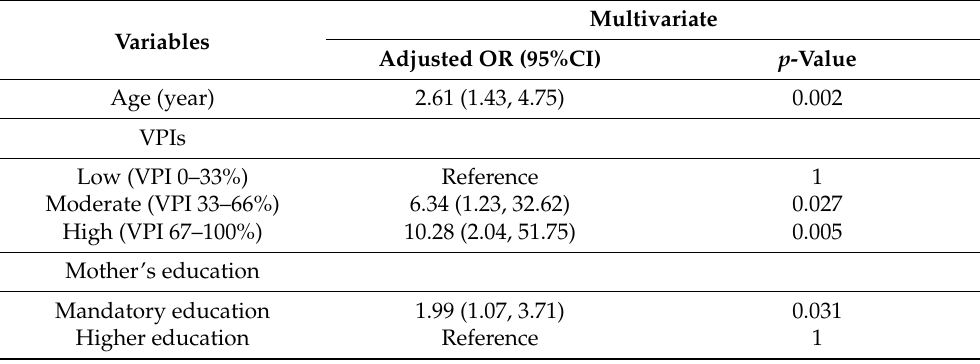
Table 4. Significant caries risk factors in the final model of multiple logistic regression